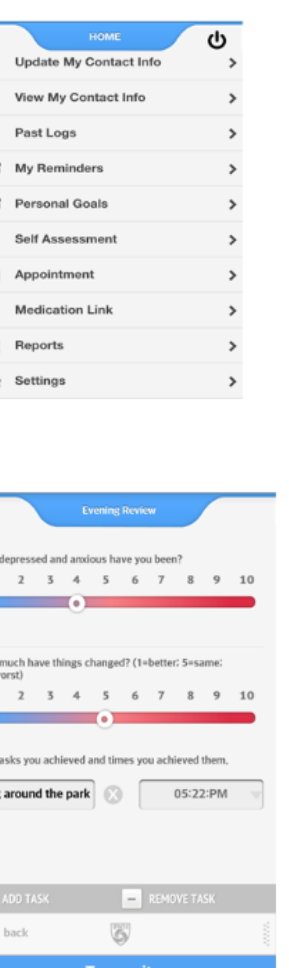
Figure 2. Pain app version 3 home page with links when scrolled down.